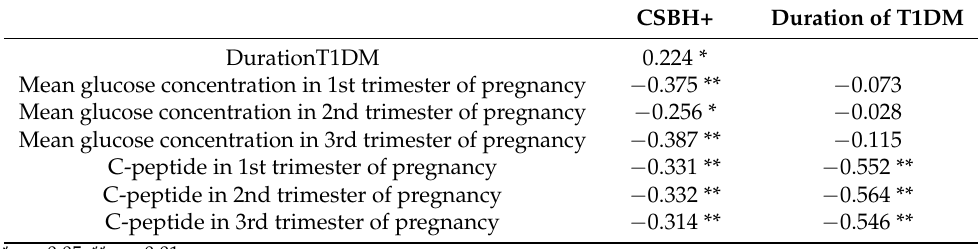
Table 3. Nonparametric correlations between the CSBH duration of T1DM, C-peptide and mean glucose concentration according to the trimesters of pregnancy.